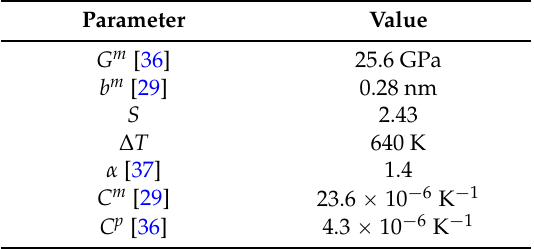
Table 2. Parameters employed in the calculations ( m : matrix; p : SiC p